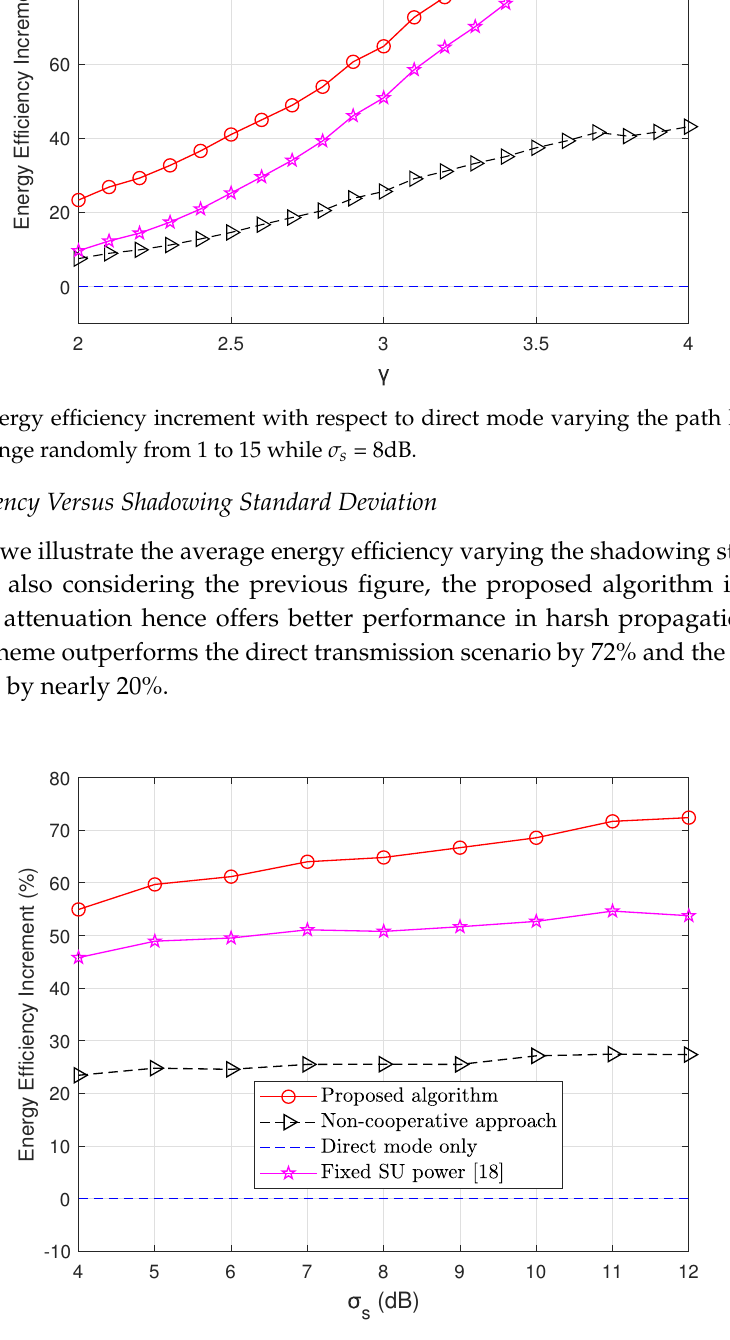
Figure 7. Energy efficiency increment with respect to direct mode versus shadowing standard deviation. M and K in this case change randomly within 1 and 15 while γ =